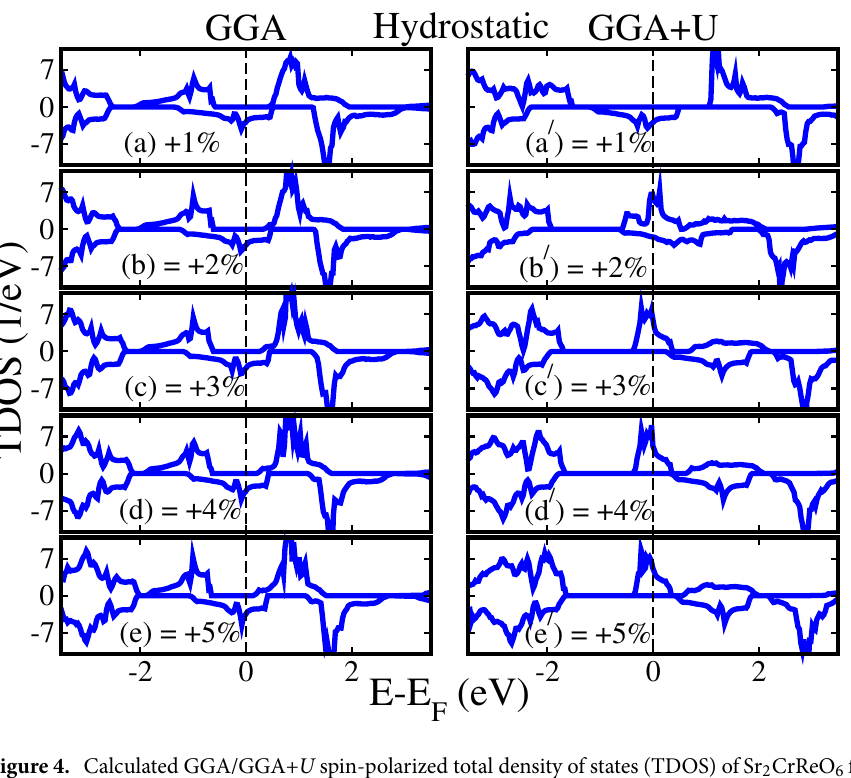
Figure 4. Calculated GGA/GGA+ U spin-polarized total density of states (TDOS) of Sr 2 CrReO 6 for ( a , a ′ ) + 1% , ( b , b ′ ) + 2% , ( c , c ′ ) + 3% , ( d , d ′ ) + 4% , and ( e , e ′ ) + 5% hydrostatic tensile strains along [111]-direction.